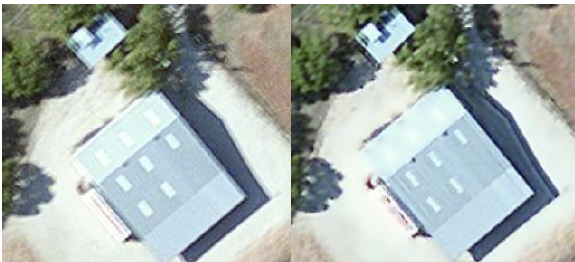
Figure 3 Subsection of an image with 6.9 pixel motion blur (left) and the de-blurred image result (right). De-blurred image still looks blurry and minor ringing artefacts are visible in the shadow concrete area. Edges have significantly